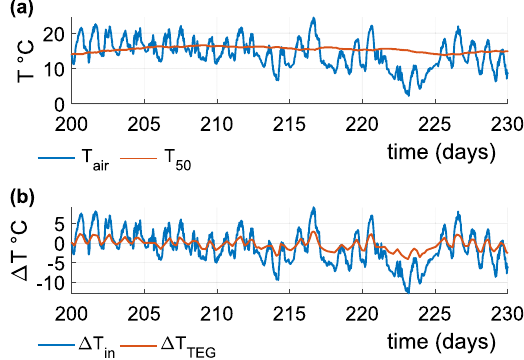
Figure 12. ( a ) Air and soil temperatures at a of depth 50cm during summer, showing a large oscillation of air temperature around soil temperature; ( b ) temperature difference at the sensor input and temperature difference on the TEG.